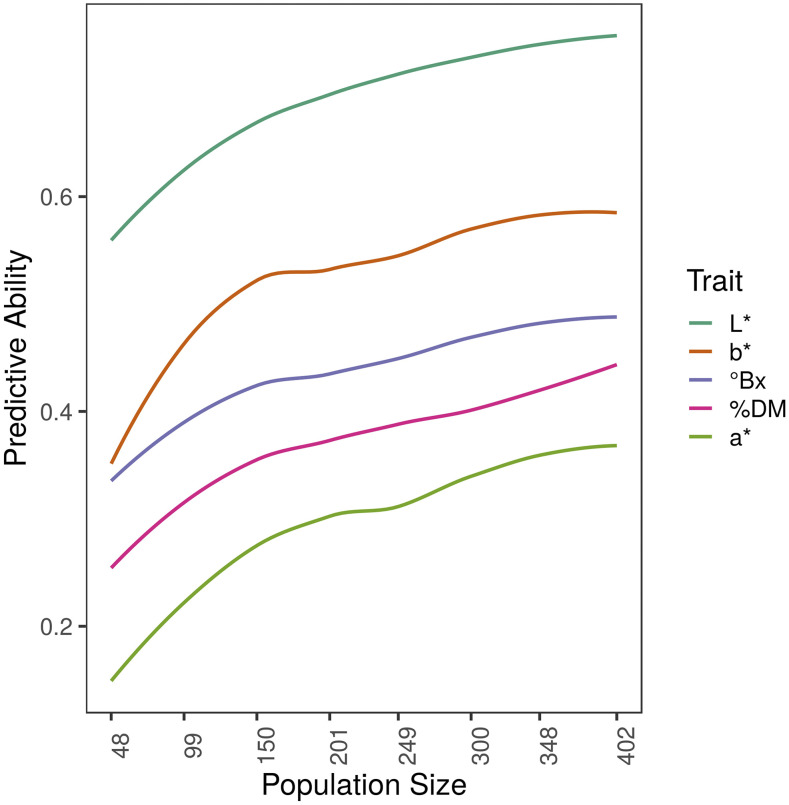
Effect of population size on predictive ability determined using CVstrat scheme.